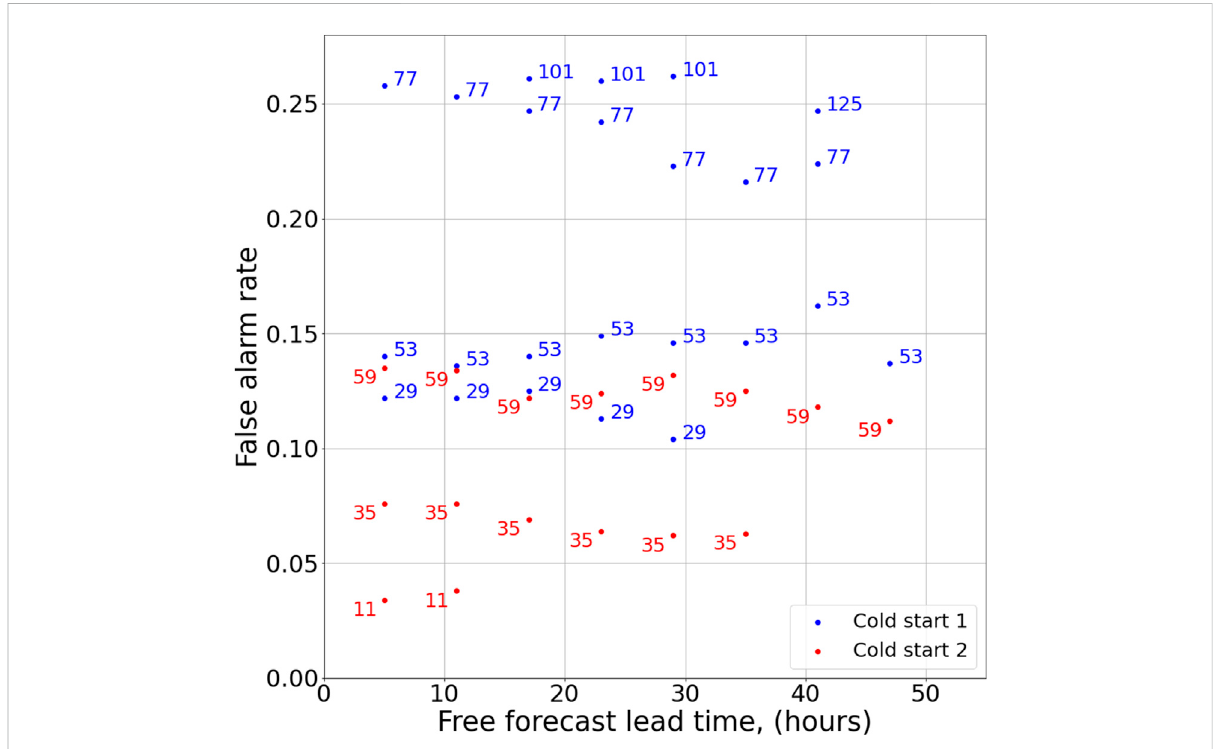
FIGURE 12 Falsealarmratesasafunctionoffreeforecastleadtimeandtimedistancefromcoldstarts.Numbersnexttothepointsrepresenthoursfromthe cold